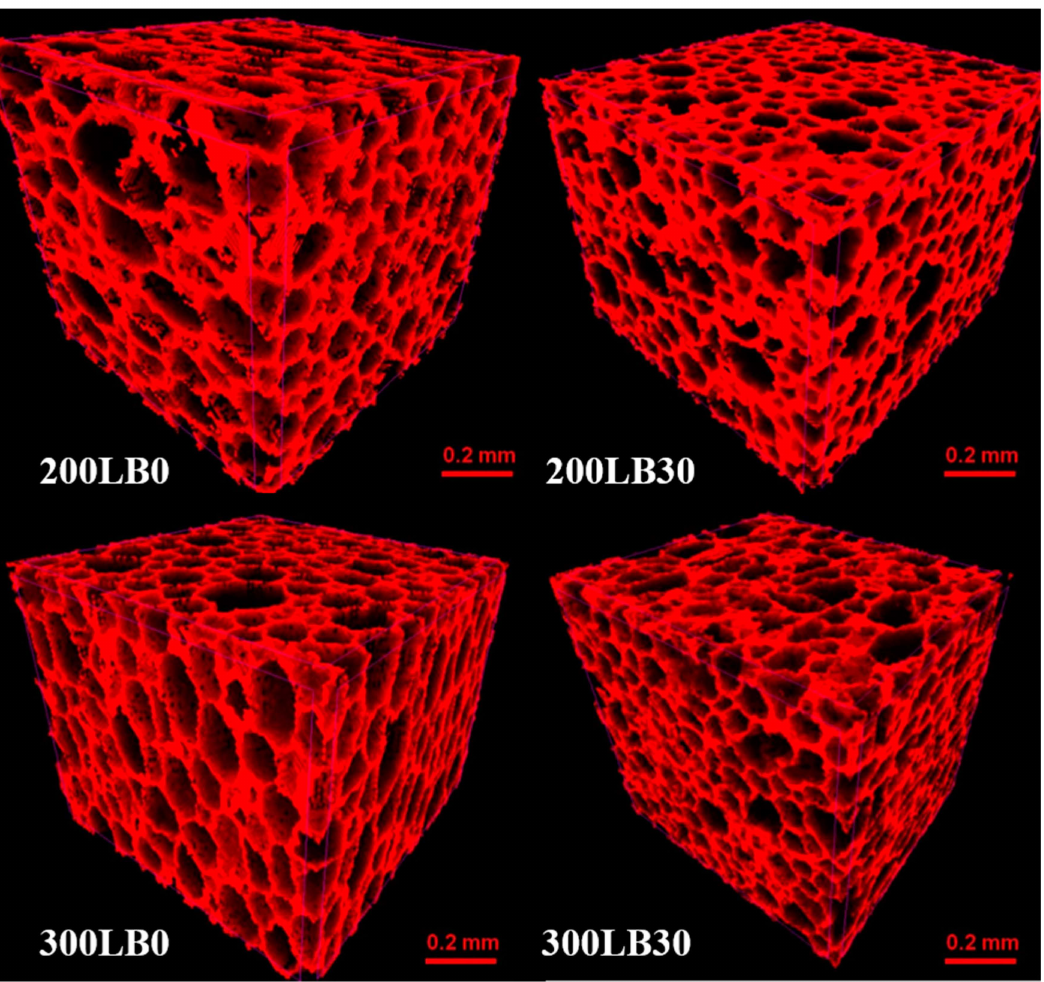
Figure 2. 3D images of foams skeletons and pores for PU foams. Table 3. Average pore diameter values and thermal insulation properties of the obtained foams.